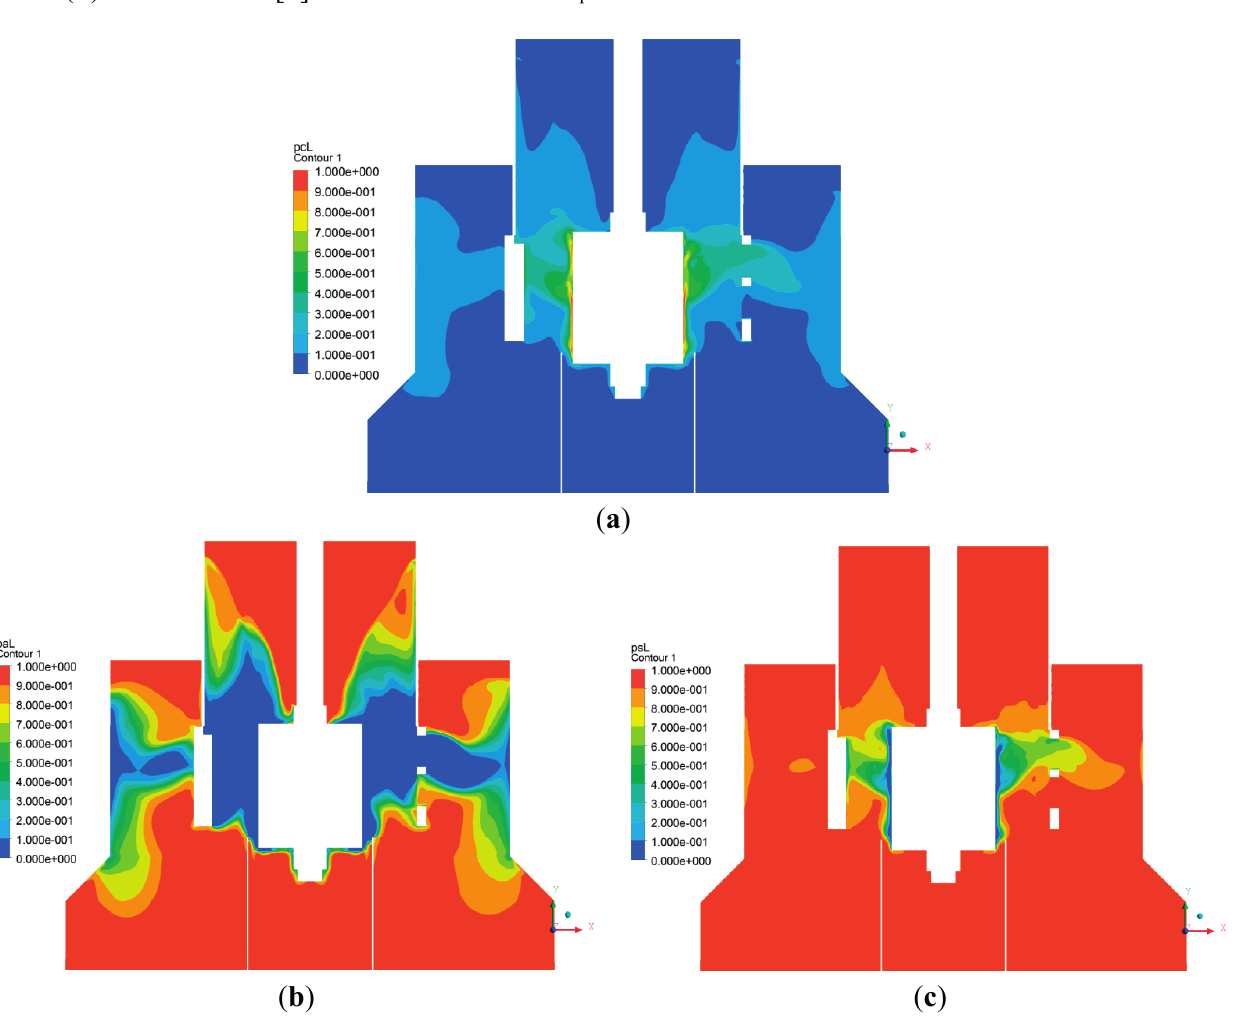
Figure 11. ( a ) Probability of collisions for d p = 100 micron; ( b ) Probability of adhesion for d p = 100 micron; ( c ) Probability of stabilization for d p = 100